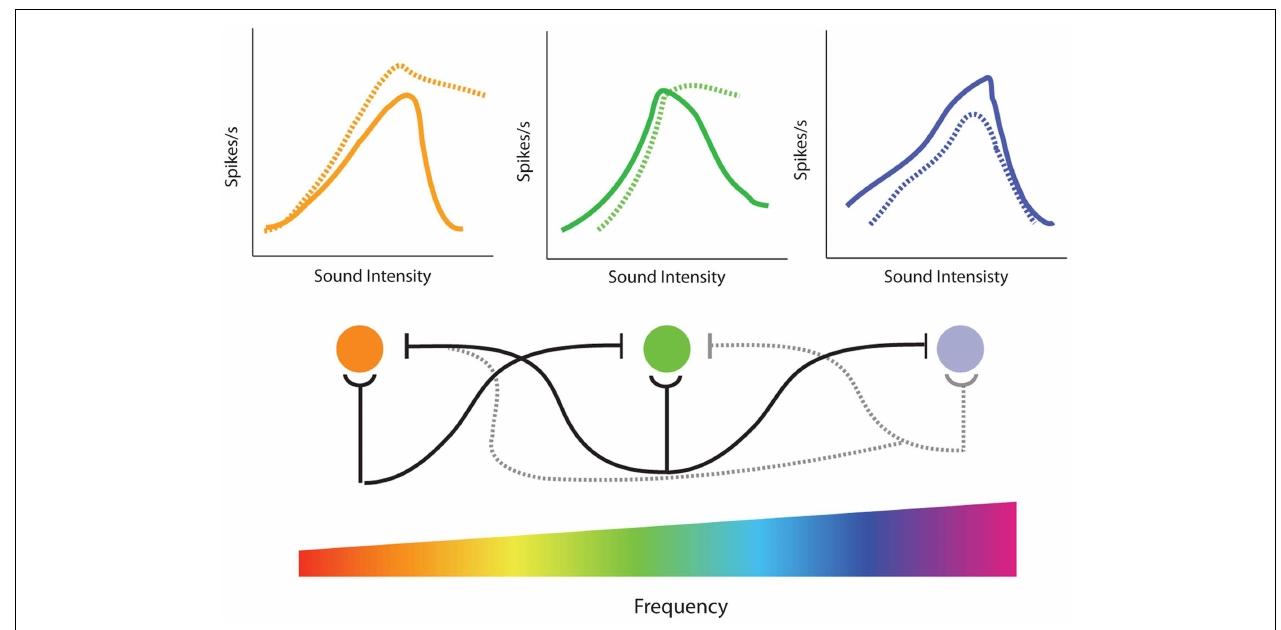
Normally, increasing sound intensity results in recruitment of lateral inhibitory projections so that many cells in the IC have non-monotonic rate-level functions (solid lines). High-frequency noise-damage not only results in decreased rate-level functions in the region of hearing loss (dotted blue line) but enhanced rate-level functions and increased monotonicity due to loss of lateral inhibition at edge frequencies (dotted orange and green lines).This loss of lateral inhibition and increase in monotonic rate-level functions could contribute to the enhancement of amplitude-level functions observed at frequencies outside of hearing loss region in the IC (see Figure 5